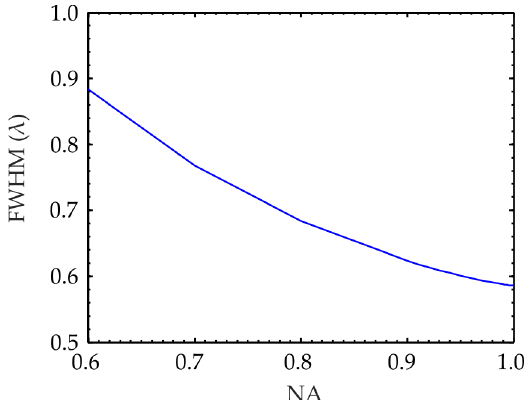
Figure 5. Diameter of the focal spot at full width at half maximum of the intensity vs. the lens numerical aperture when focusing a circularly polarized plane wave.